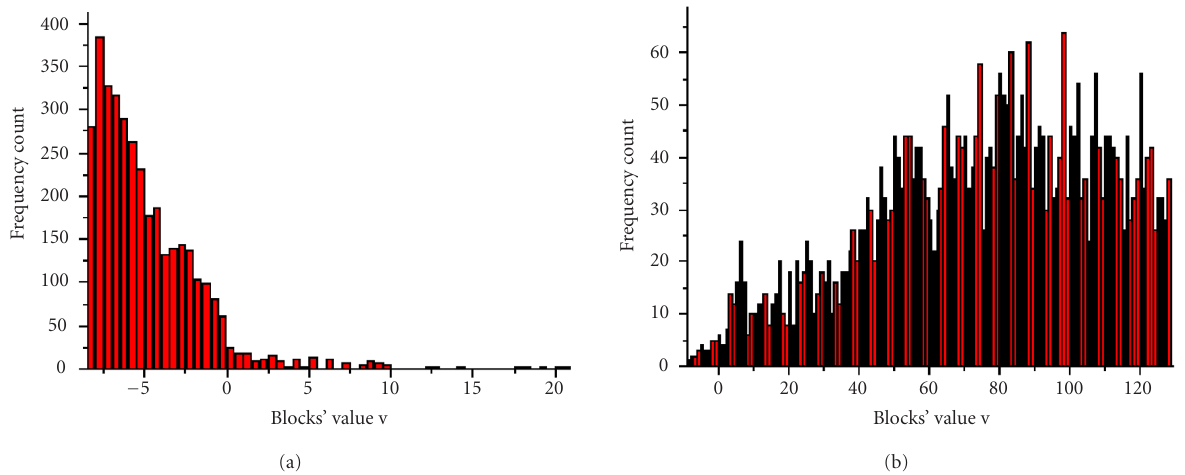
Figure 27: The value of the (a) background and (b) foreground class in linear classification in FVC2002 DB4.